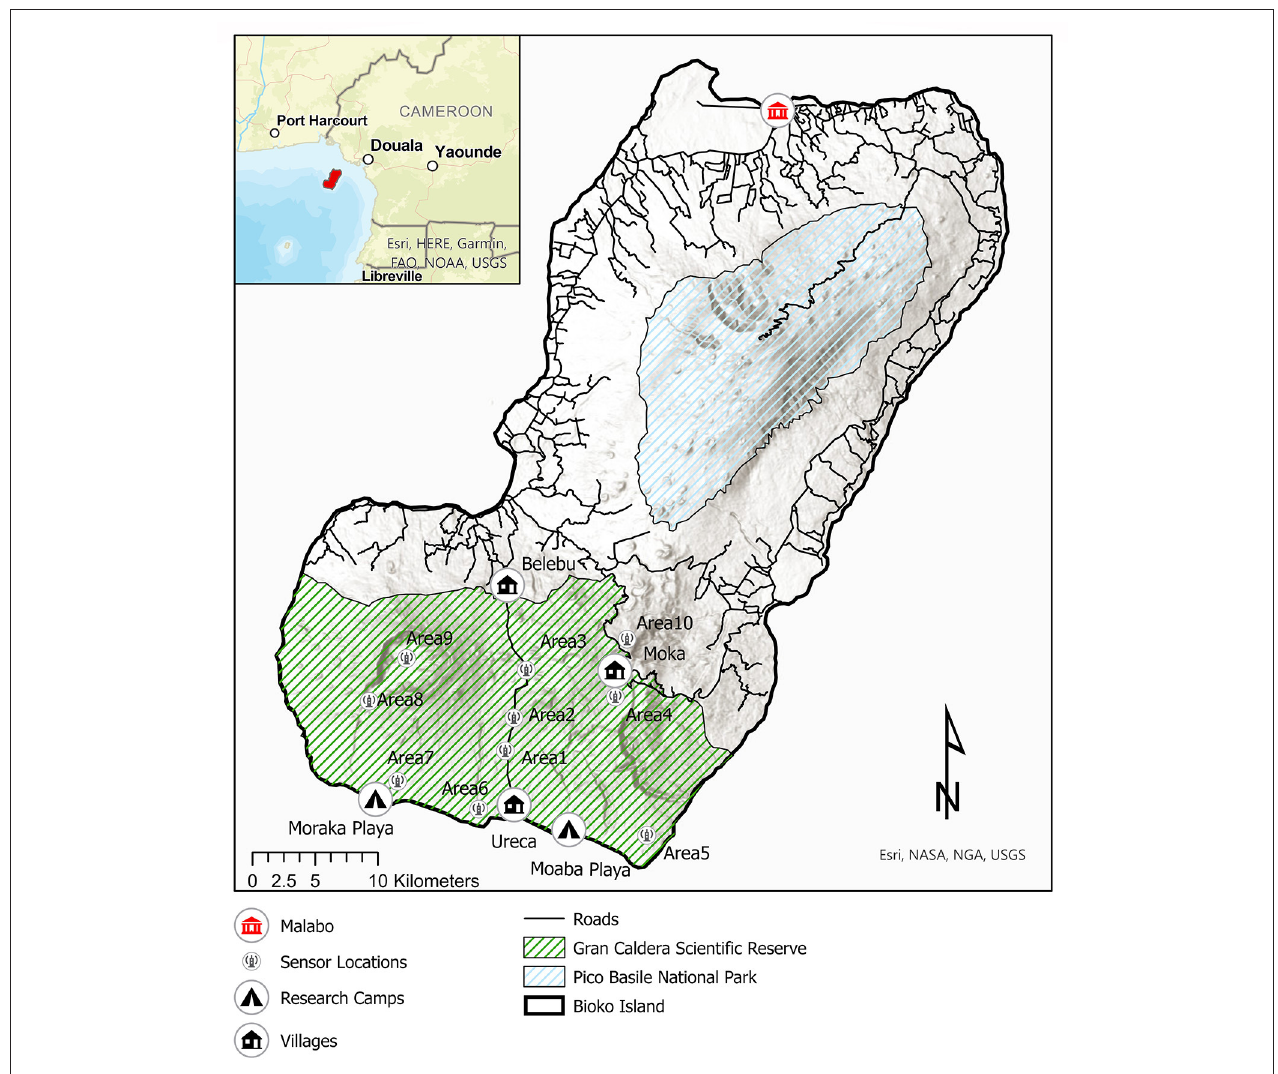
FIGURE 1 | Distribution of protected areas, roads, villages, research camps and the 10 monitored areas inside the Gran Caldera de Luba Scientific Reserve (shaded green) in Bioko Island, Equatorial Guinea. Area 9 is located within the Gran Caldera Volcánica de Luba u Ose, one of the most isolated locations in Bioko. The city of Malabo, capital of Equatorial Guinea, harbors the largest wildmeat markets in